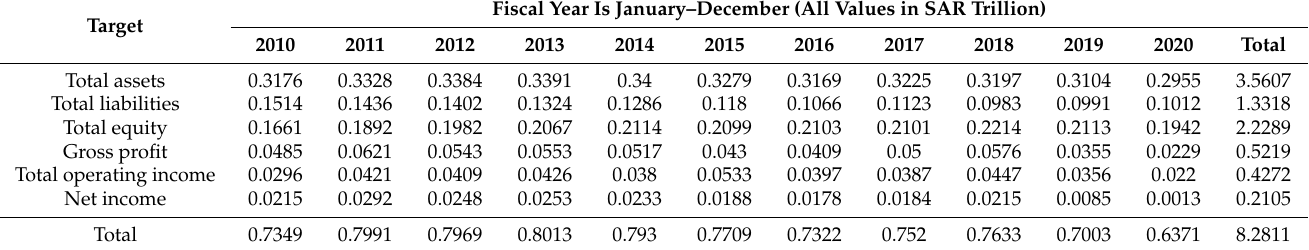
Table 4. Financial data from the SABIC in coded